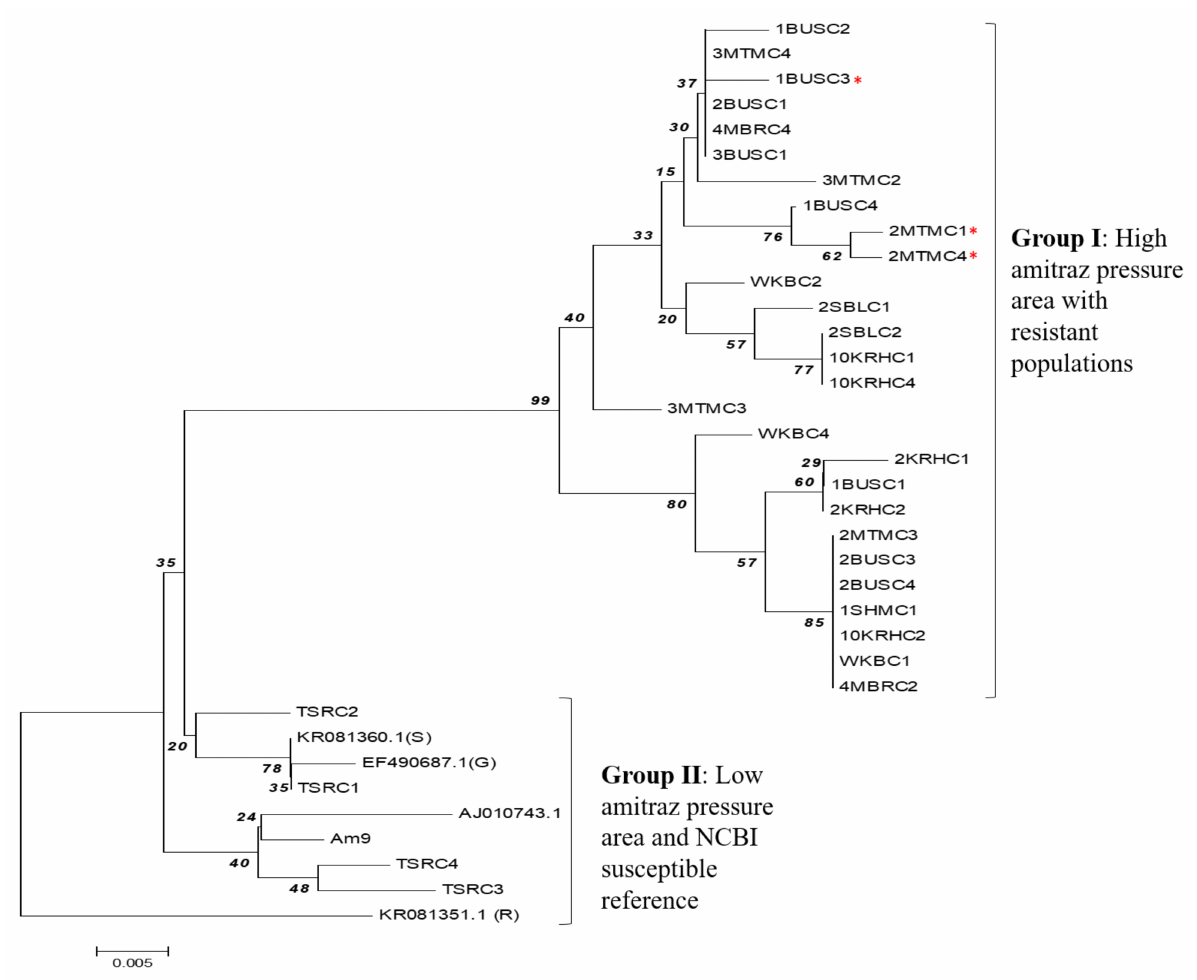
Figure 5. Phylogenetic tree constructed from R. ( B .) decoloratus OCT/Tyr receptor gene partial coding nucleotide sequences. Group I, OCT/Tyr gene sequence from tick populations from high acaricide pressure area (central and western Uganda); Red asterisk (*) indicates clones from tick populations with history of amitraz resistance. Group II, tick populations from low acaricide pressure/control area (east and northern Uganda); OCT/Tyr sequence from GenBank: KR081360.1 (S), Susceptible R. ( B .) mi- croplus from South Africa; EF490687.1(G), Susceptible R. ( B .) microplus Gonzalez strain (America); KR081351.1 (R), amitraz-resistant R. ( B .) microplus from South Africa. AJ010743.1 (octopamine-like, G-protein coupled receptor from R. ( B .) microplus strain from Australia). The maximum composite likelihood method was used to construct the phylogenetic tree with bootstrap value of 1000